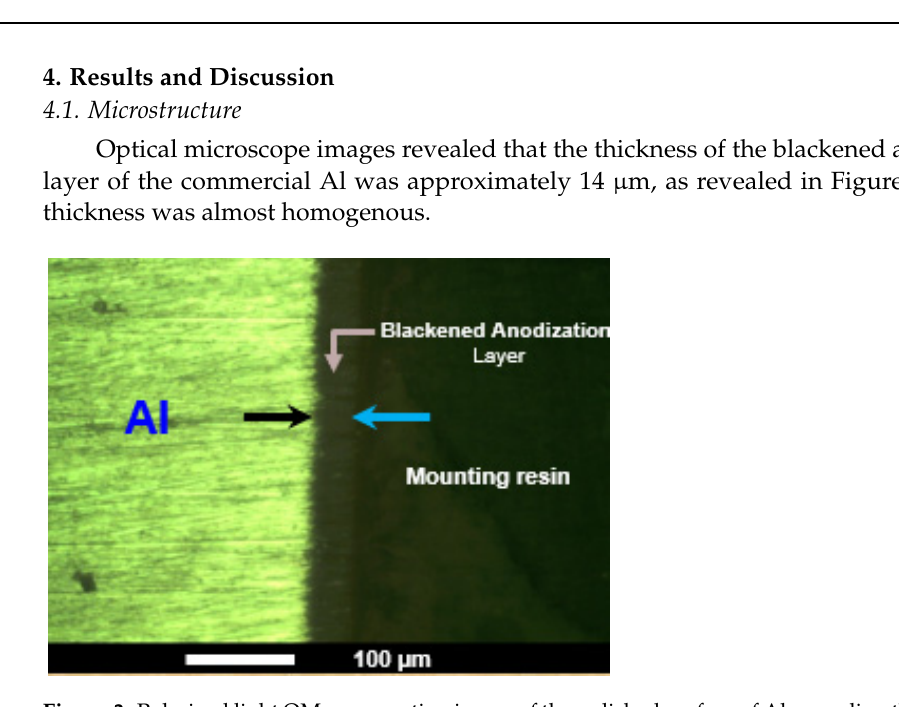
Figure 3. Polarized light OM cross-section image of the polished surface of Al, revealing the blackened anodization layer.